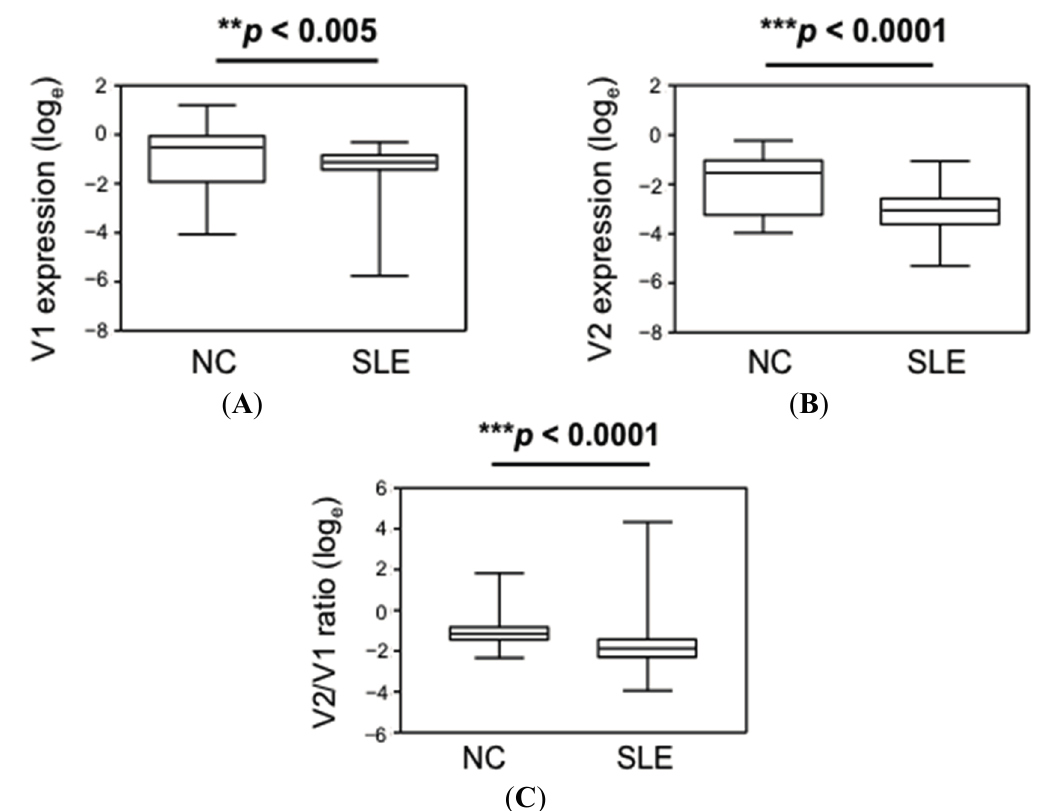
Figure 2. Reduced expression of CLEC16A isoforms in PBMCs of SLE patients. Box and whisker plots comparing the expression of ( A ) V1; ( B ) V2; and ( C ) V2/V1 ratio between normal controls (NC, n = 86) and SLE patients (SLE, n = 181). V1 and V2